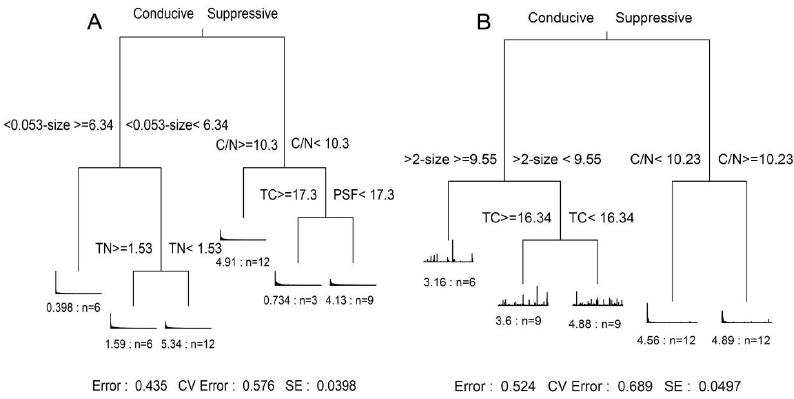
Figure 4. Multivariate regression tree (MRT) analysis of the relationship between the community structure of the bacteria ( A ) and fungi ( B ) and soil attributes across the various soil fractions. <0.053- size, the percentage of <0.053 mm-sized soil fraction; >2-size, the percentage of >2 mm-sized soil fraction; TC, total carbon; TN, total nitrogen; and C/N, carbon and nitrogen ratio. The bar plots show the mean relative abundance of OTUs at each terminal node, and the distribution patterns of abundance represent the dynamics of the response to the soil attributes among each split. The numbers under the bar plots indicate the number of samples within each group.